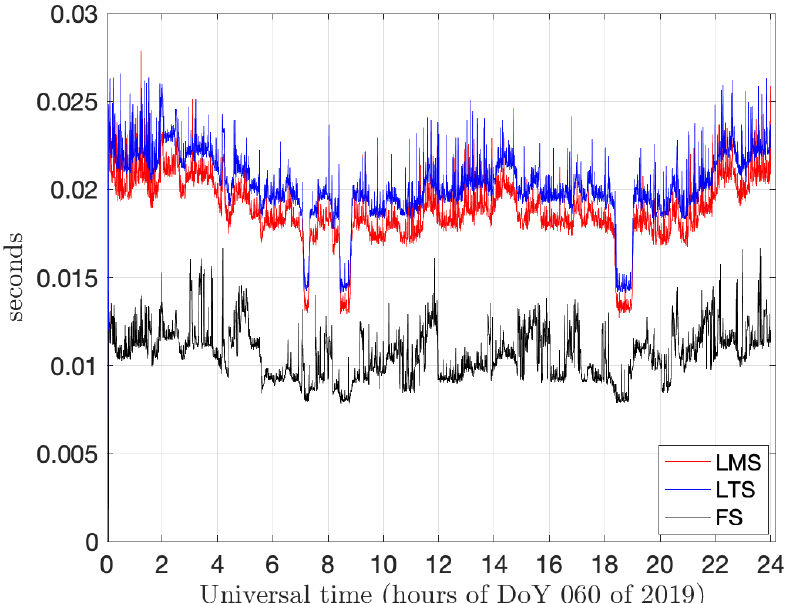
Figure 5. Comparison of computing times for LMS, LTS and FS on time windows of 10